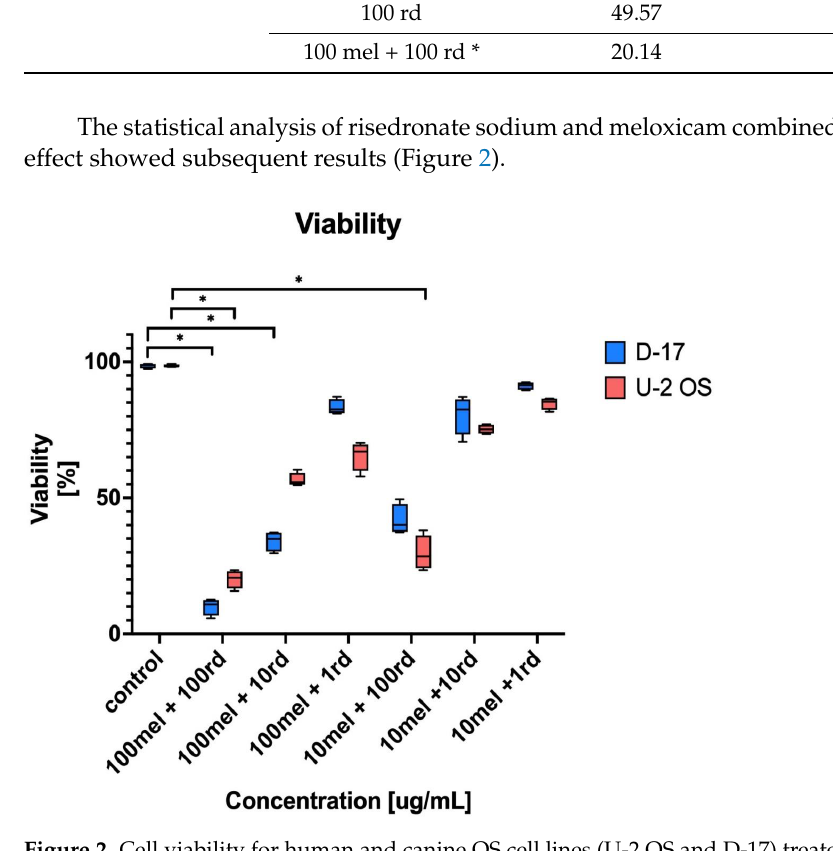
Figure 2. Cell viability for human and canine OS cell lines (U-2 OS and D-17) treated with combined risedronate sodium (rd) and meloxicam (mel) administration (* p < 0.05). The statistical analysis proved that the cytotoxic effect of 100 mel + 100 rd and 100 mel + 10 rd combinations against D-17 were, statistically, significantly different to the negative control (control). In the case of U-2 OS, the cytotoxicity of 100 mel + 100 rd and 10 mel + 100 rd combinations proved statistically significant differences compared to the negative control.